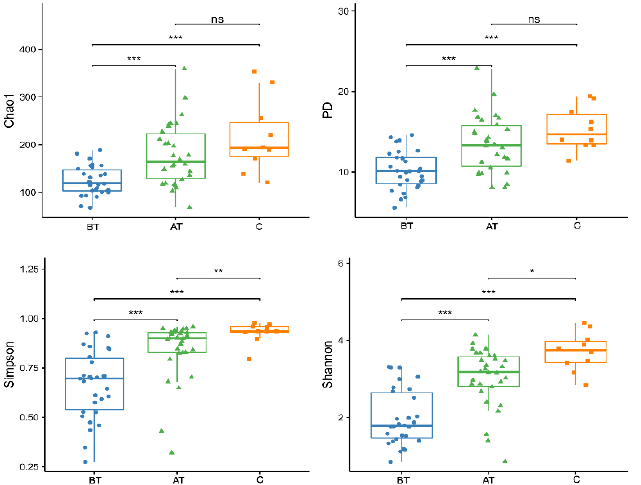
Figure 1. Alpha diversity indexes (Chao1, Simpson, PD, and Shannon) of the pre-treated (BT), after-treatment (AT), and control (C) groups. ns = no statistical significance, * = p <0.05, ** = p <0.01, *** = p < 0.001.